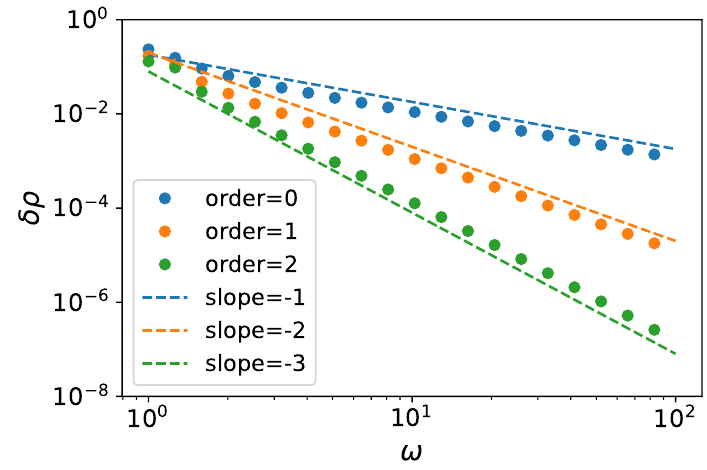
( t ) and ρ ( N ) ( t ) [ Eq. (73) ] plotted against ness ness